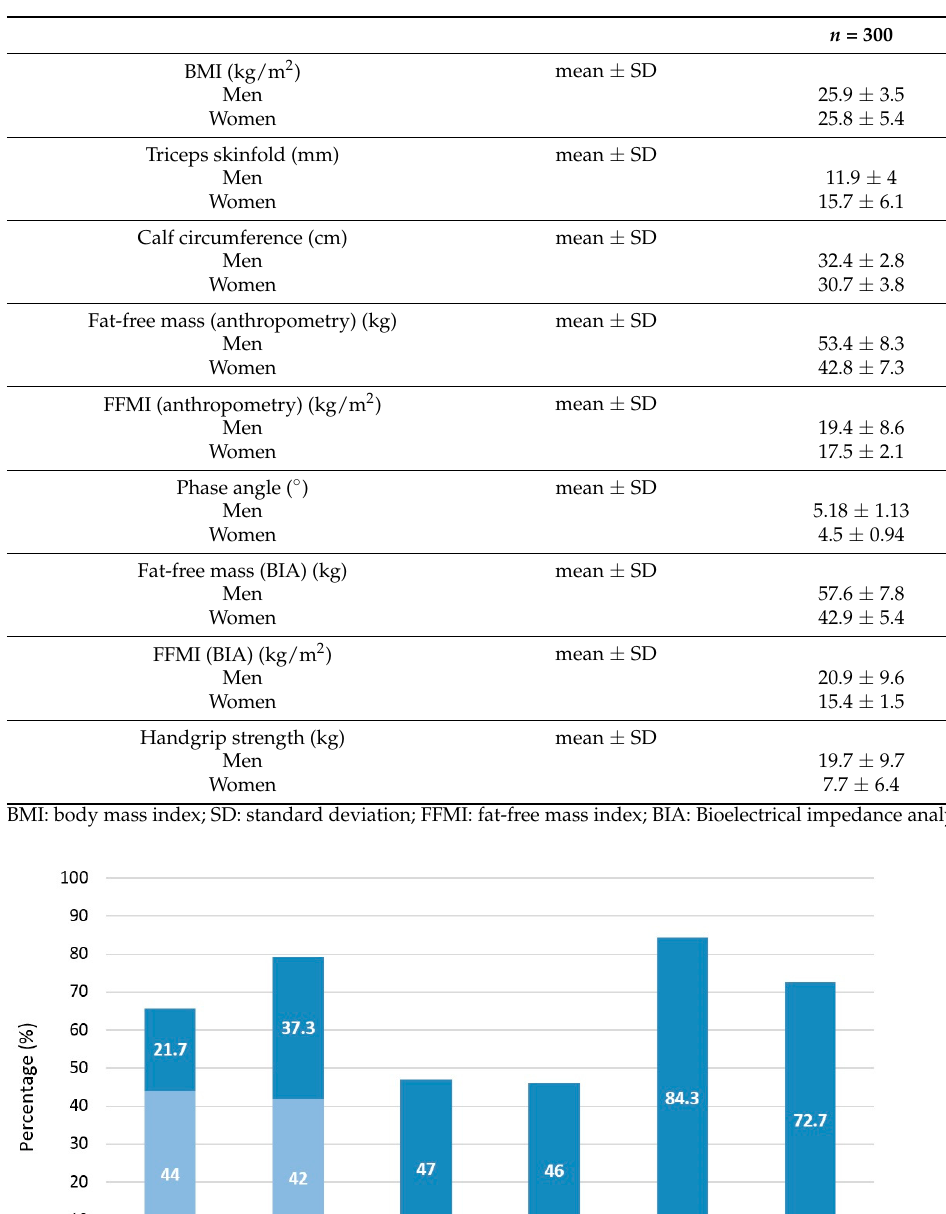
Table 2. Body composition parameters.